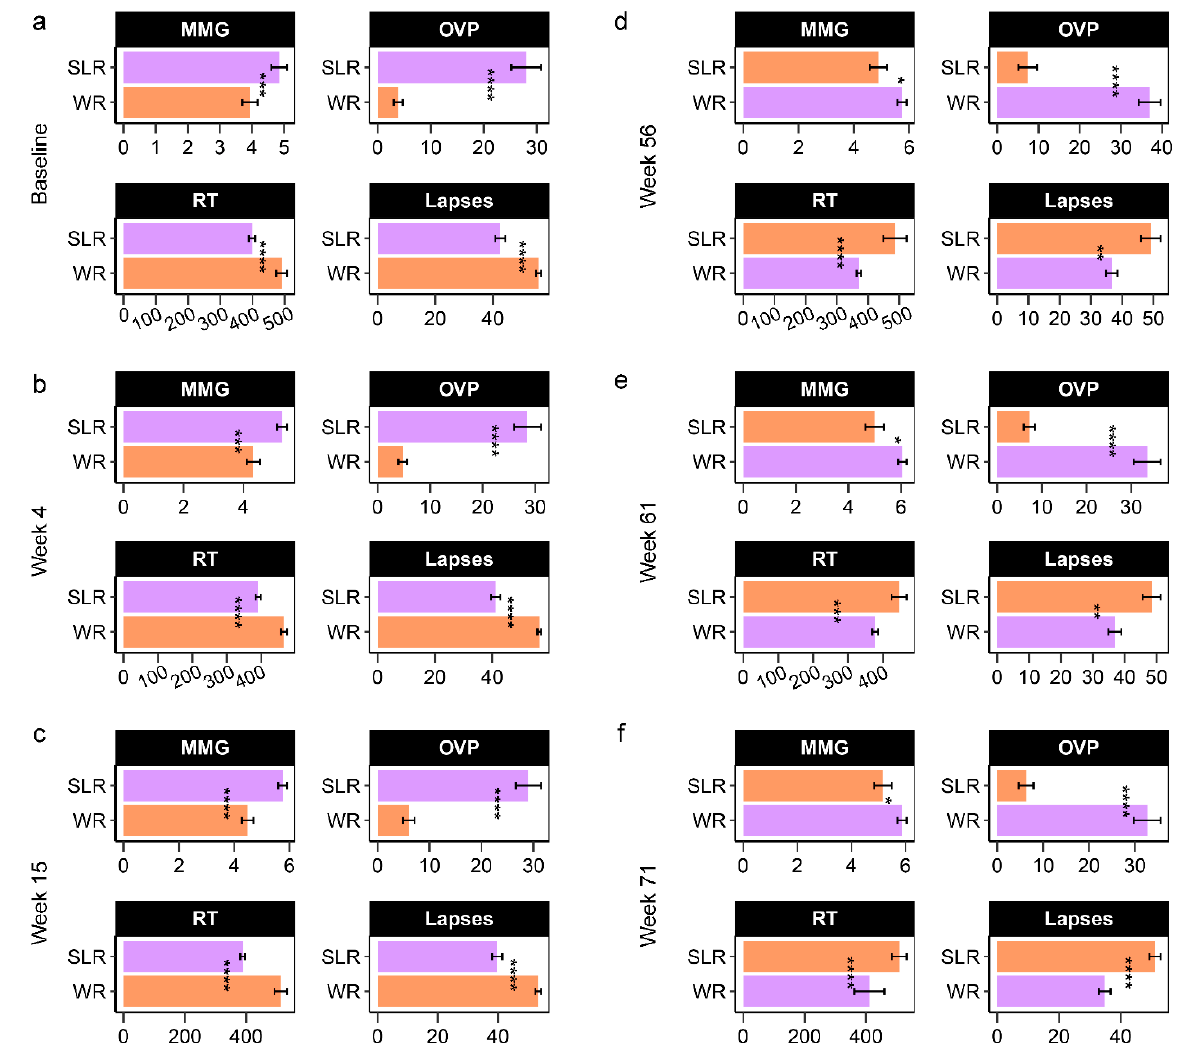
Figure 4. Barplots displaying the cognitive performance of school-aged children in a non-randomized clinical trial (Phase I: ( a – c ), Phase II: ( d – f )). The difference in mean between the control (WR) and intervention (SLR) groups was determined using either the two-sample t -test or the Wilcoxon rank sum test with Benjamini-Hochberg (BH) p -value correction ( q -value). **** q < 0.0001, *** q < 0.001, ** q < 0.01, * q < 0.05. MMG, memory matching game, which denotes Corsi block spans; OVP, overall performance (%); RT, reaction times (millisecond); lapses (millisecond). WR, white rice (control); SLR, Sinlek rice intervention.